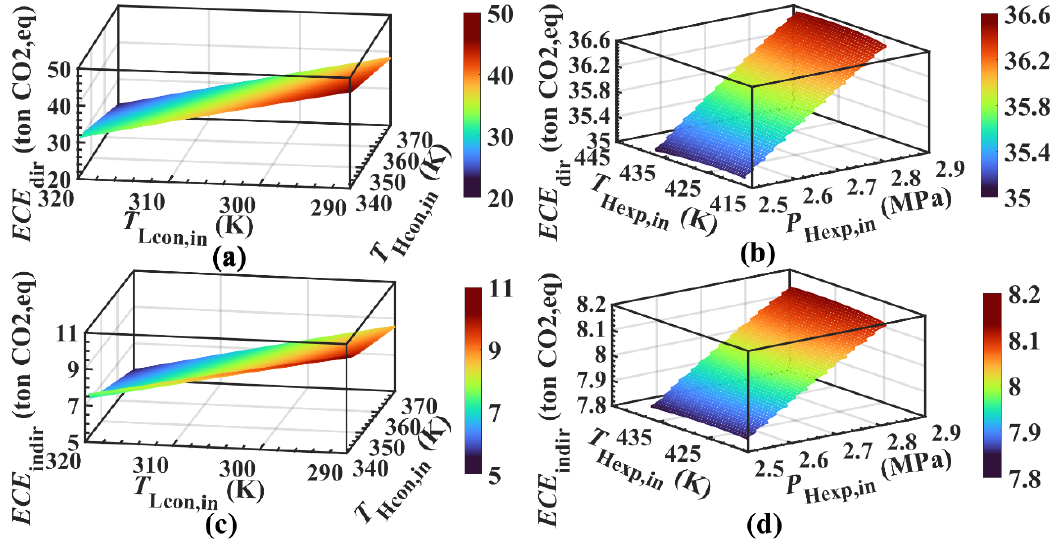
Figure 18. Influence characteristics of key variables on direct ECE and indirect ECE. (a) Effect characteristics of the inlet temperature of the condenser in different loops on direct ECE. (b) Effect characteristics of the expander on the HT cycle direct ECE. (c) Effect characteristics of the inlet temperature of the condenser in different loops on indirect ECE. (d) Effect characteristics of the expander on the HT cycle indirect ECE.